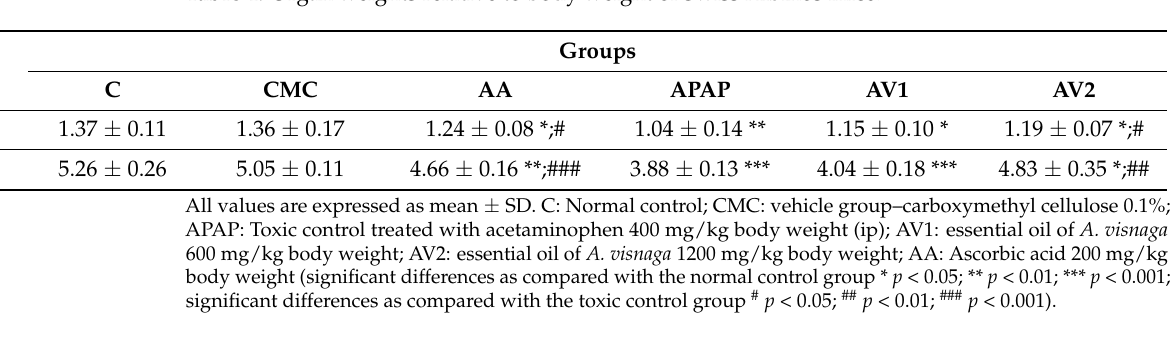
Table 4. Organ weights relative to body weight of Swiss Albinos